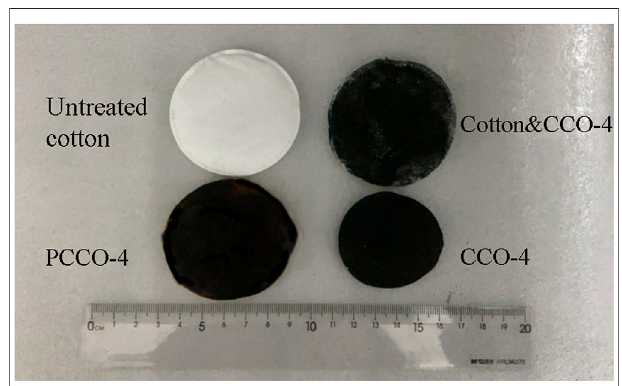
FIGURE 3 | Physical picture of untreated cotton, cotton deposited with CCO-4, carbonized cotton heated by a fl at plate at 400 ° C, and cotton pyrolyzed in a tube furnace at 400 ° C.